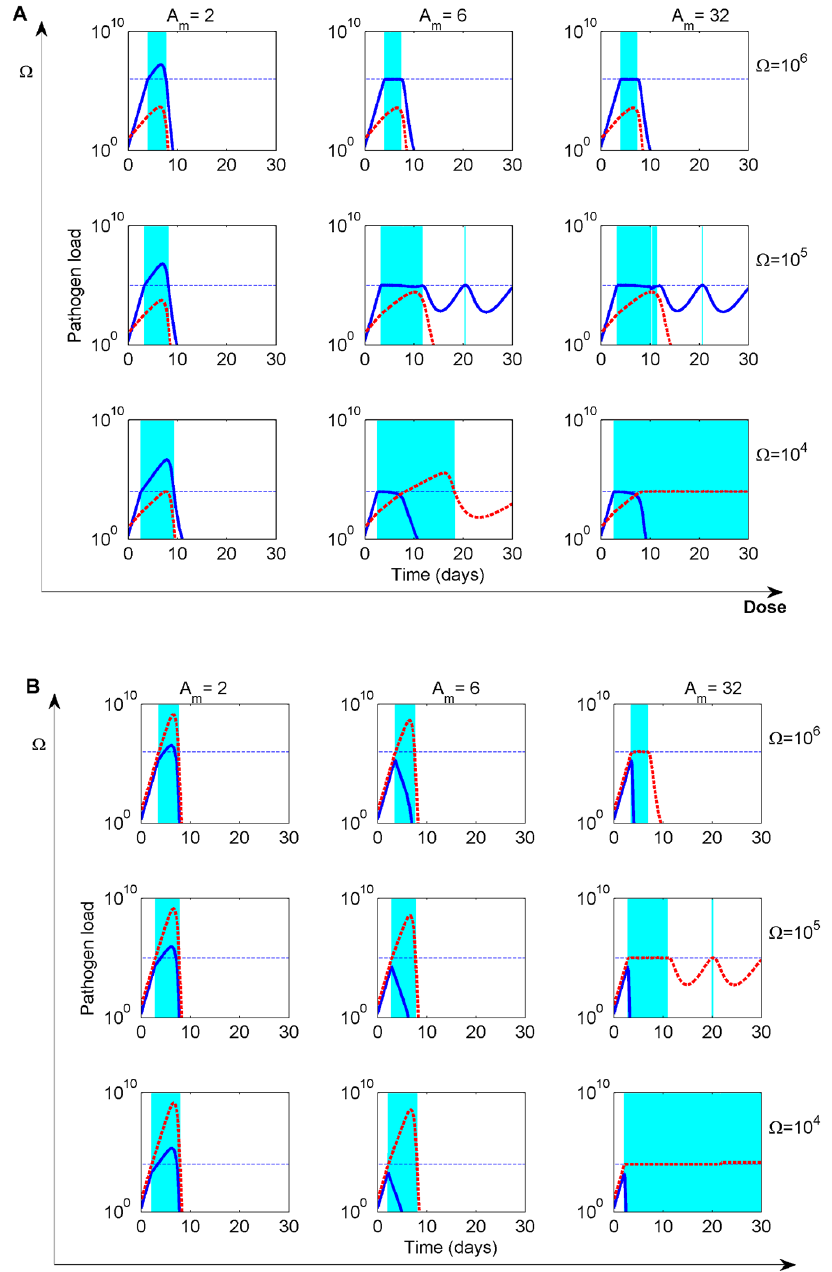
Fig 7. Adaptive treatment dynamics depends on dose A m and the symptom threshold Ω . A) High cost ; A (cid:6)(cid:6) (cid:8) ¼ ½ 3 : 3 ; 11 (cid:8) . B) Low cost of resistance ( c = 0.1) where of resistance ( c = 2.2) where ½ A (cid:6) m m ½ A (cid:6) ; A (cid:6)(cid:6) (cid:8) ¼ ½ 3 : 3 ; 32 (cid:8) . All other parameters as in Table 1 ( r 5 ). Drug-sensitive pathogen dynamics 0 = 3.3, k = 10 m m are plotted in blue solid lines, and drug-resistant pathogen dynamics are given by the red dashed lines. In allow bacterial growth during treatment thus co-stimulation of immunity. adaptive treatment, doses below A (cid:6) m Higher doses are scaled according to pathogen density B ( t ) (cid:1) Ω , which maintains the total infection load at Ω , can be scaled down if necessary (A top until suf fi cient host immunity has been mounted. Doses above A (cid:6)(cid:6) m right panel), or used in full (B top panel) guaranteeing the no-growth condition. Under σ = 2 as in Table 1, at too low symptom thresholds ( Ω < k ), the treatment starts too early, and immunity does not reach the critical level. When coupled with high dosage of treatment, this results in chronic infection being maintained inde fi nitely, unless other killing mechanisms or non-speci fi c immune defenses are present at such low bacterial densities and can assist in clearance.